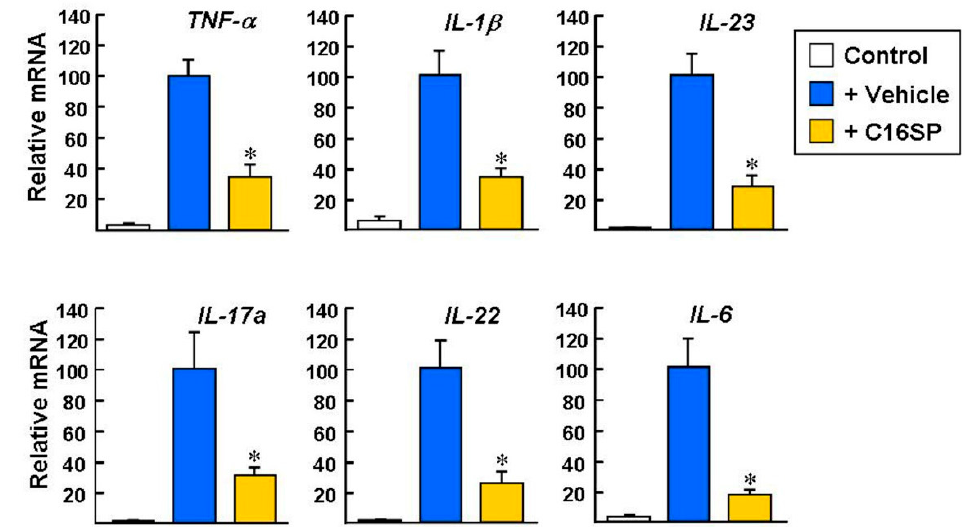
Figure 6. Real-time qPCR analysis of the expression levels of inflammatory cytokines induced by IMQ. Mice dorsal skins were treated with IMQ plus vehicle, C16, or C16SP for four consecutive days and then the dorsal skin samples were analyzed. Control indicates mice that received cream without IMQ. Gapdh was used as a loading control. Data are from three independent experiments. * p < 0.0001 versus IMQ/vehicle-treated group.